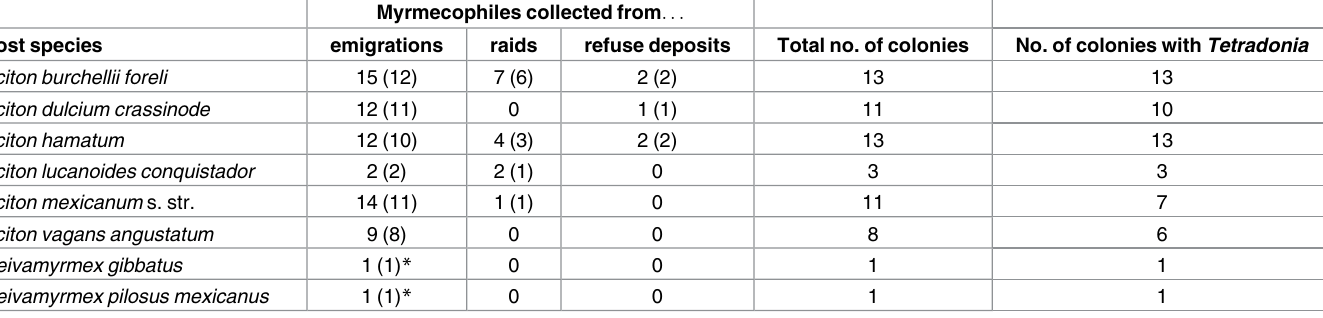
Table 1. Overview of samples. Shown is the number of host emigrations, raids and refuse deposits from which Tetradonia beetles were collectedand ana- lyzed. Numbers in parenthesesgive the number of different colonies of a given host species. Note that the focus of the study was to systematically sample host emigrations, while specimens were only collected opportunistically from raids and refuse deposits. Detailedsample information is given in S1 Table. Myrmecophiles collected from